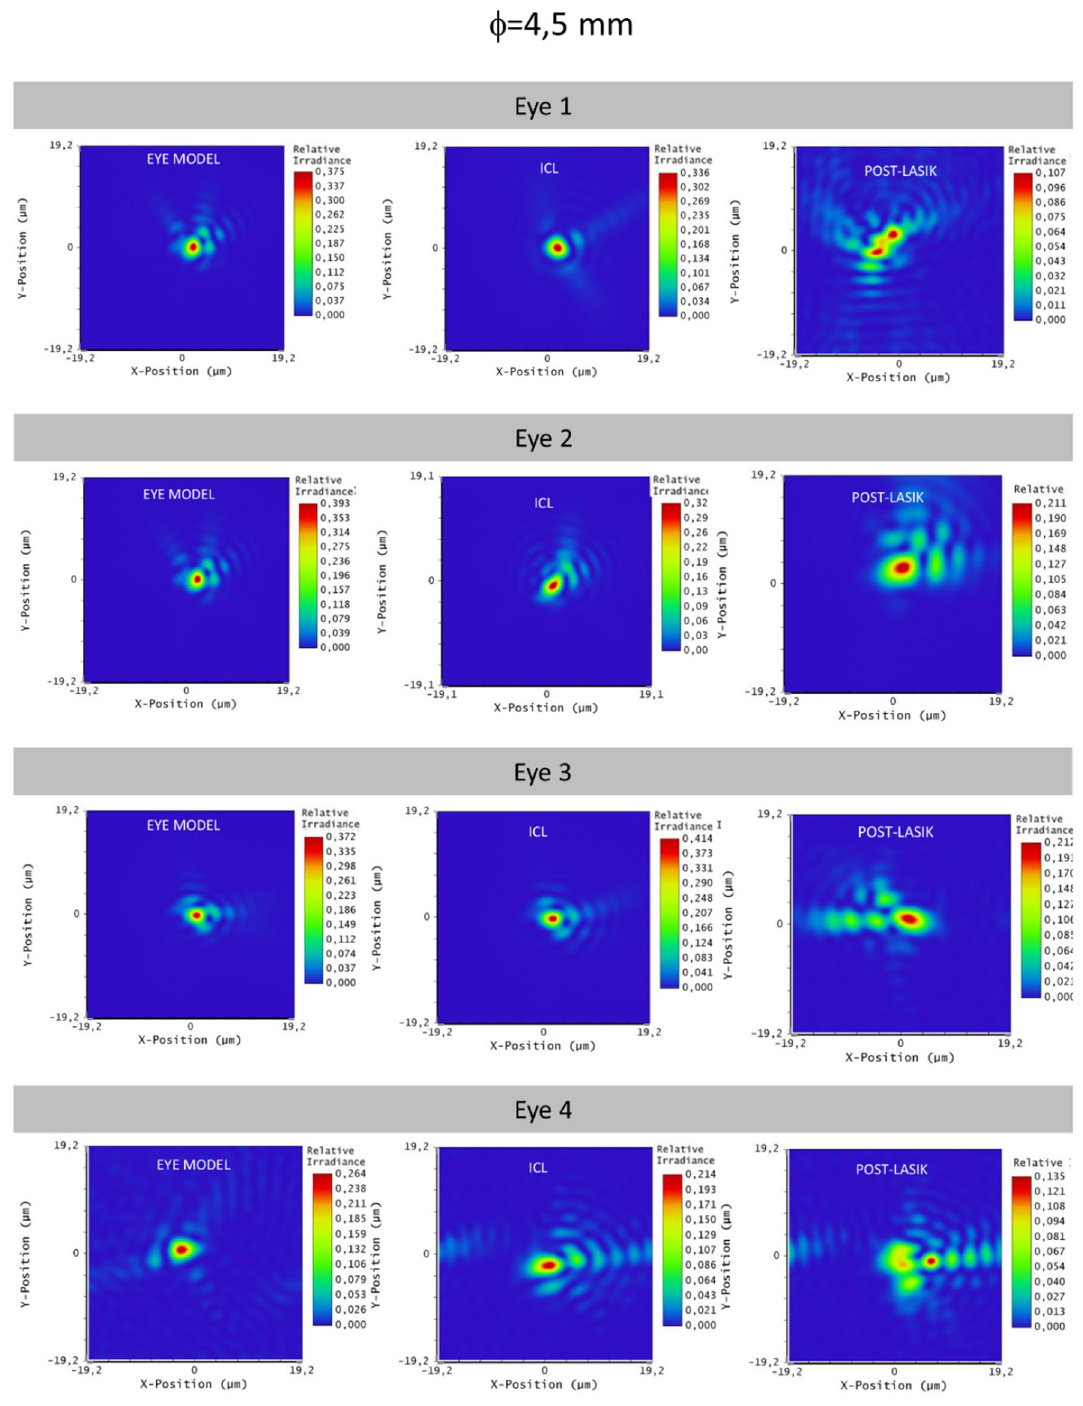
Figure 4. Point Spread Function (PSF) of the three eye models (eye model, ICL model and post-LASIK model) for the pupil size of 4.5